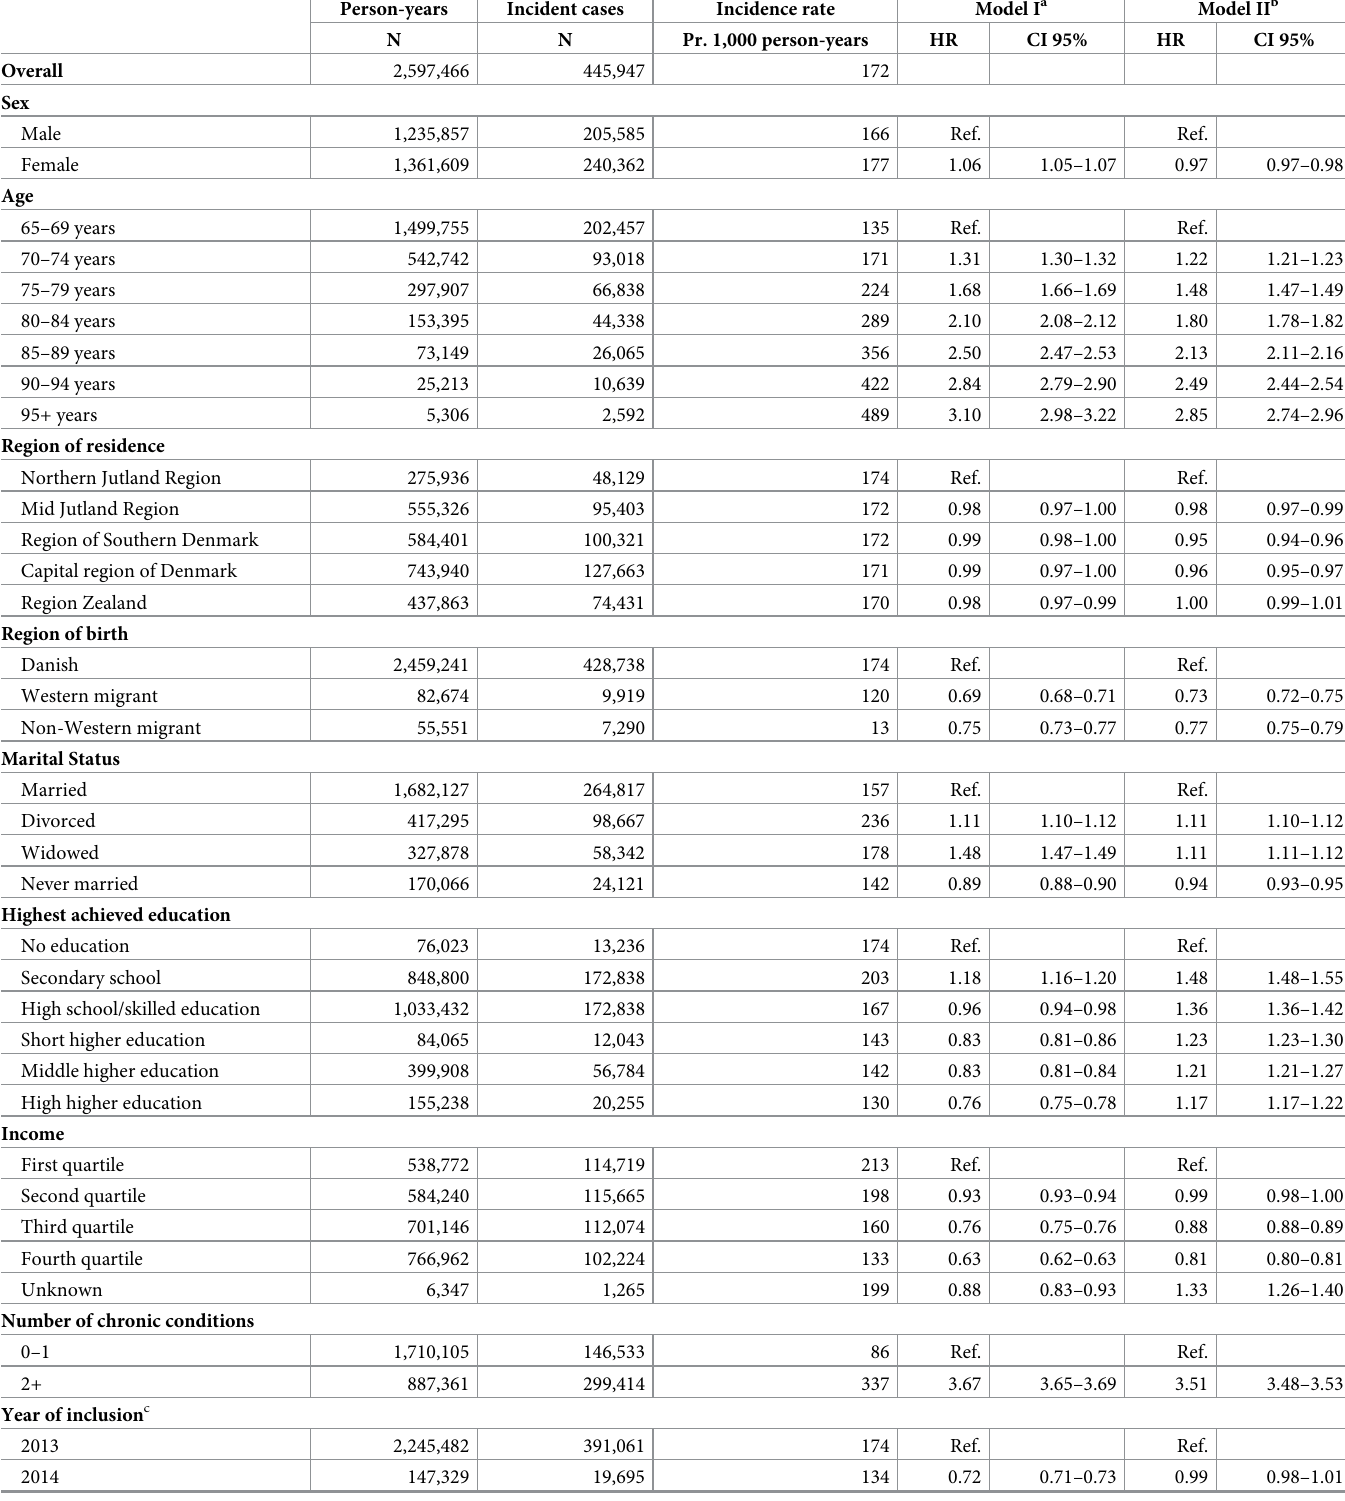
Table 3. Incidence of polypharmacy among the 949,919 study participants who were not exposed to polypharmacy at the time of